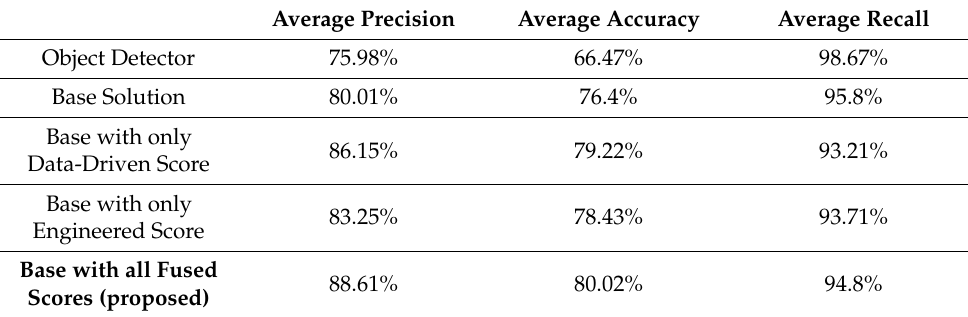
Table 6. Ablation study with respect to several